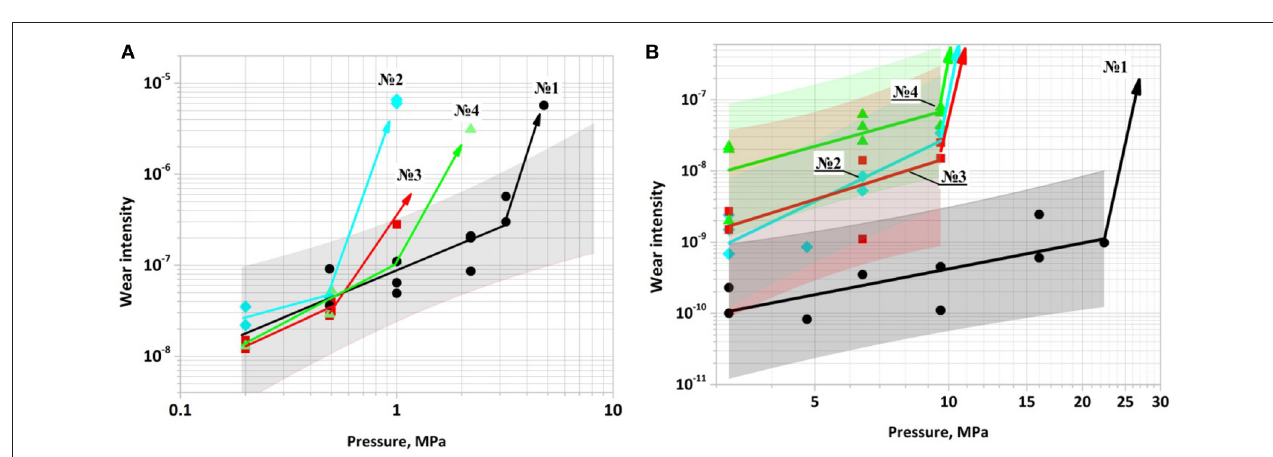
FIGURE 2 | The dependence of the wear intensity (data points, approximation lines and 95% confidence bands) of the investigated alloys on the contact pressure in two modes: (A) without lubricant, (B) with lubricant. (No. 1–No. 4 are numbers of alloys).